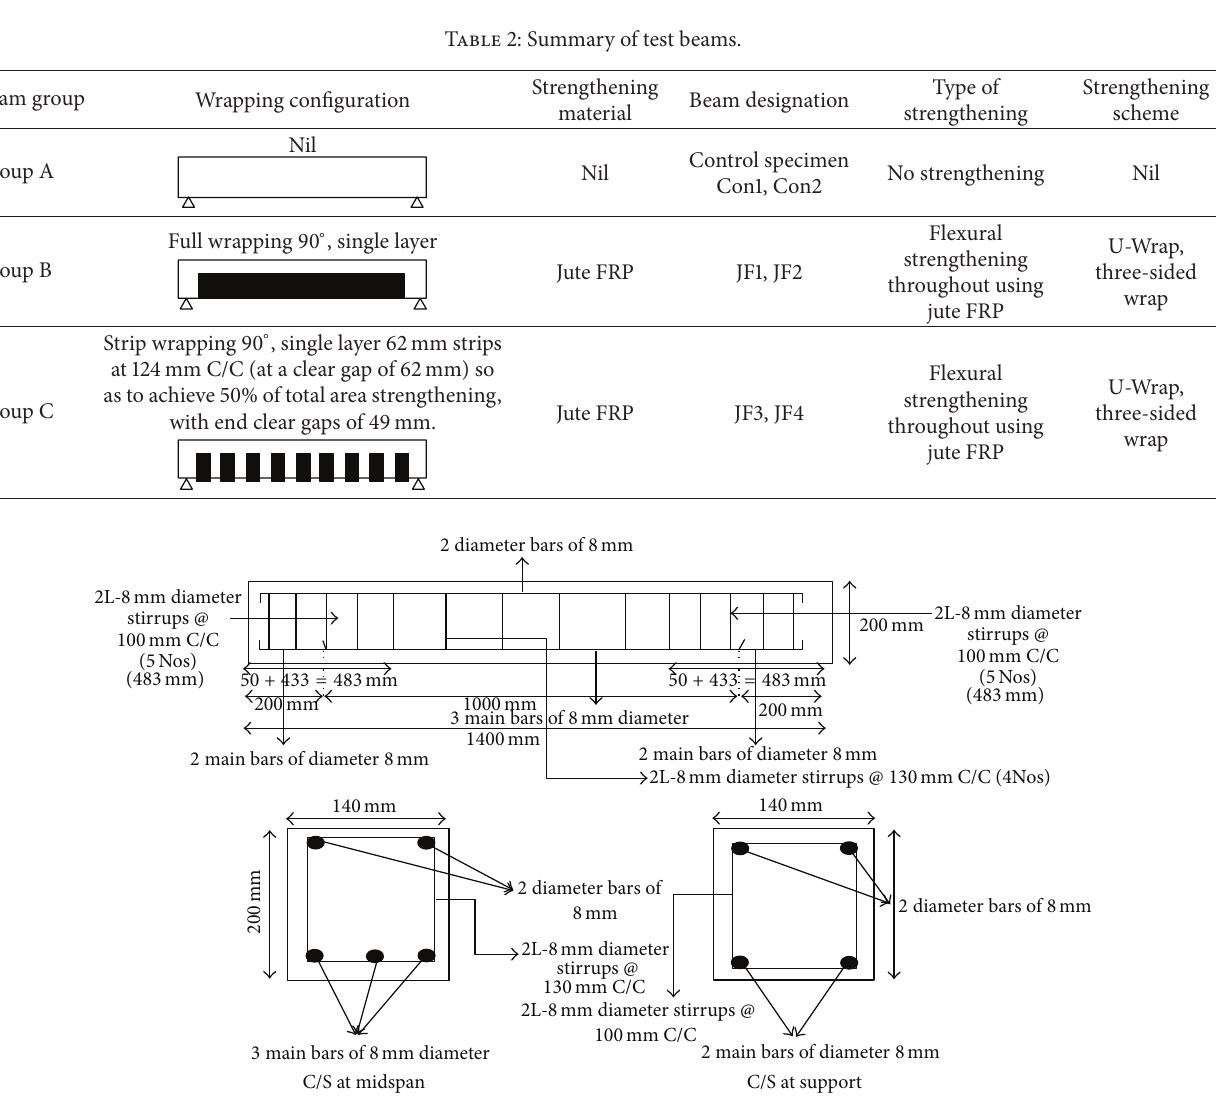
Figure 4: Reinforcement detailing of RCC beams (all sets, group A, B, and C).